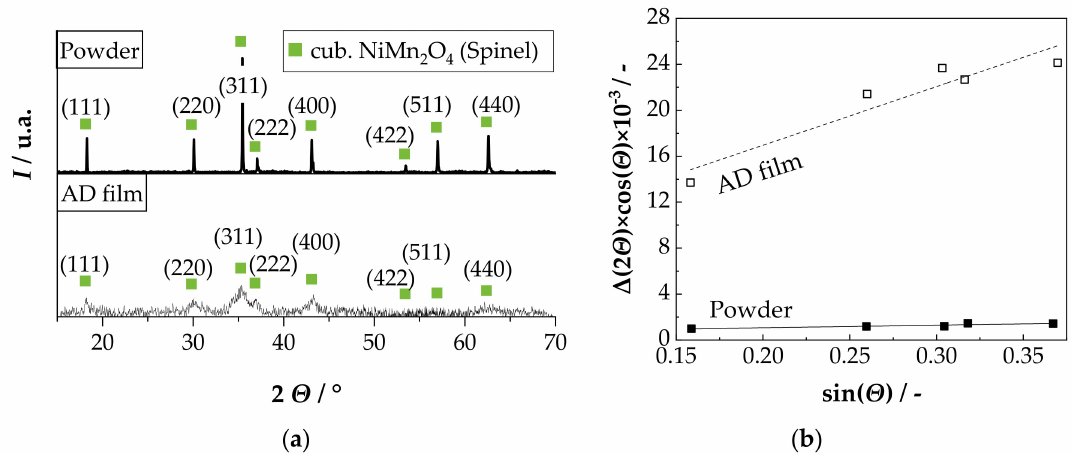
Figure 3. ( a ) Comparison of the XRD patterns of the starting powder and an aerosol deposited film in the as-deposited state; ( b ) Williamson–Hall plot of the starting powder and the AD film in the as-deposited